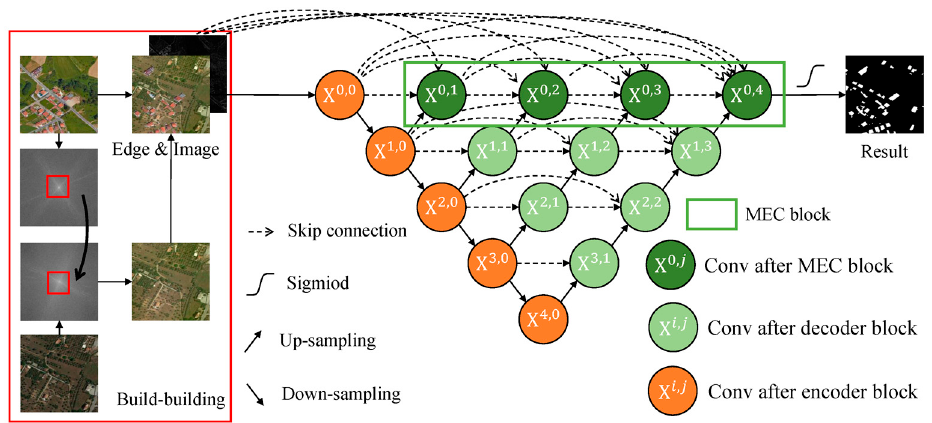
Figure 2. The structure of MEC-Net.